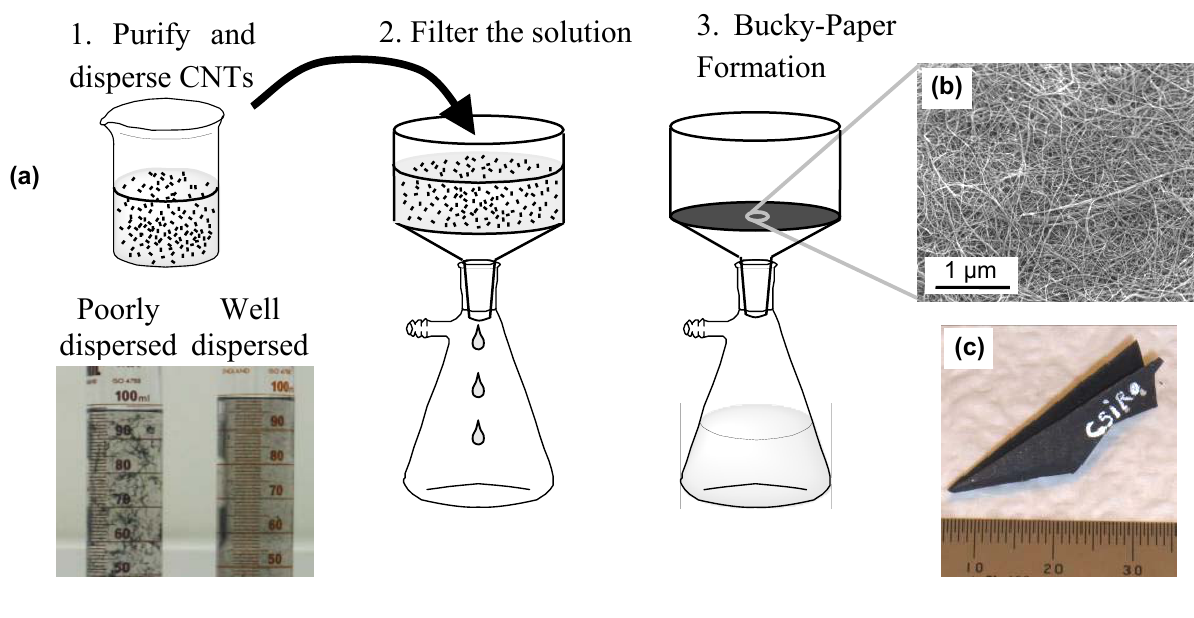
Figure 2. (a) Process for manufacturing Bucky-papers, (b) SEM image showing the Bucky-paper surface and (c) Bucky-paper origami aeroplane demonstrating their flexibility mechanical